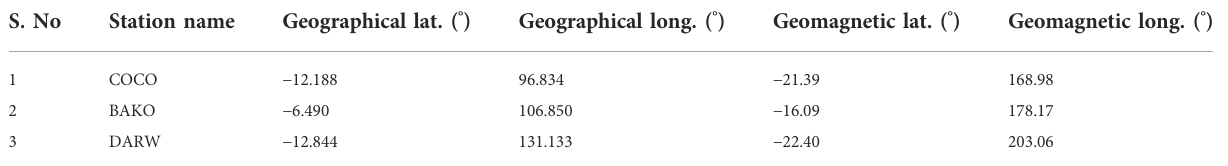
TABLE 1 Geographical and geomagnetic coordinates of the GPS